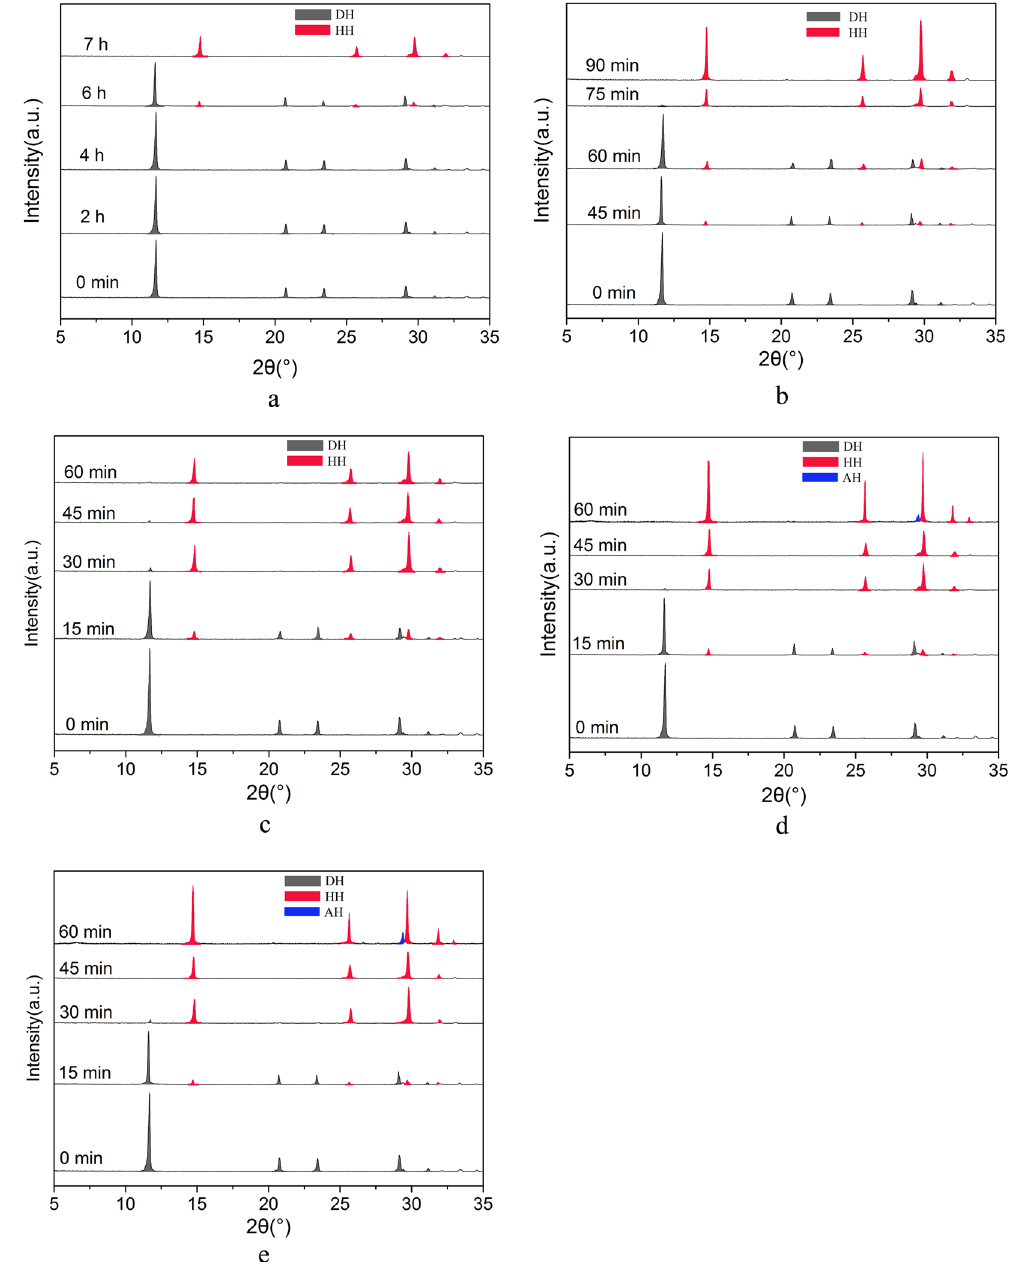
Figure 1. XRD patterns of the crystal products at interval time during the phase transformation in the presence of different KCl concentration in glycerol (65 wt%)-water solutions at 90 °C (( a ) 0; ( b ) 1%; ( c ) 3%; ( d ) 5%; ( e )